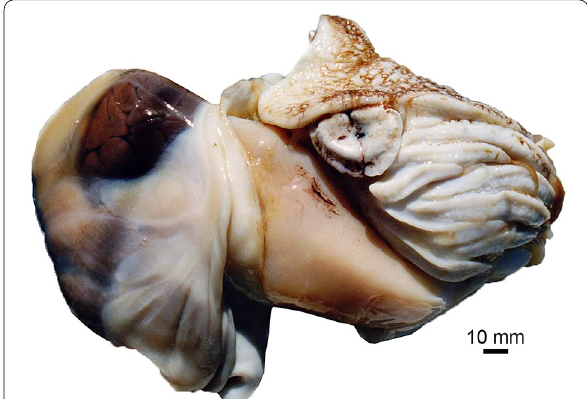
Fig. 4 Soft parts of Recent Nautilus pompilius , removed from its conch. Note how the mantle extends ventrally in this case. The specimen was kept in deep water for four days in a plastic container to avoid predation. Photo by courtesy of Tomoki Kase (Tokyo)